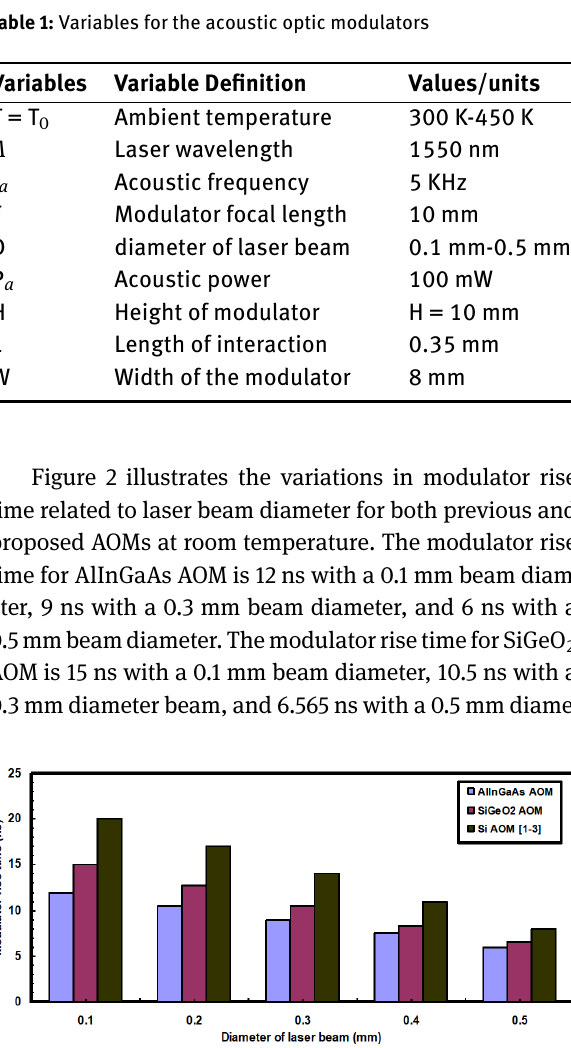
Figure 2: Variations in modulator rise time in relation to laser beam diameter for the previous and the proposed AOMs at room tempera- ture